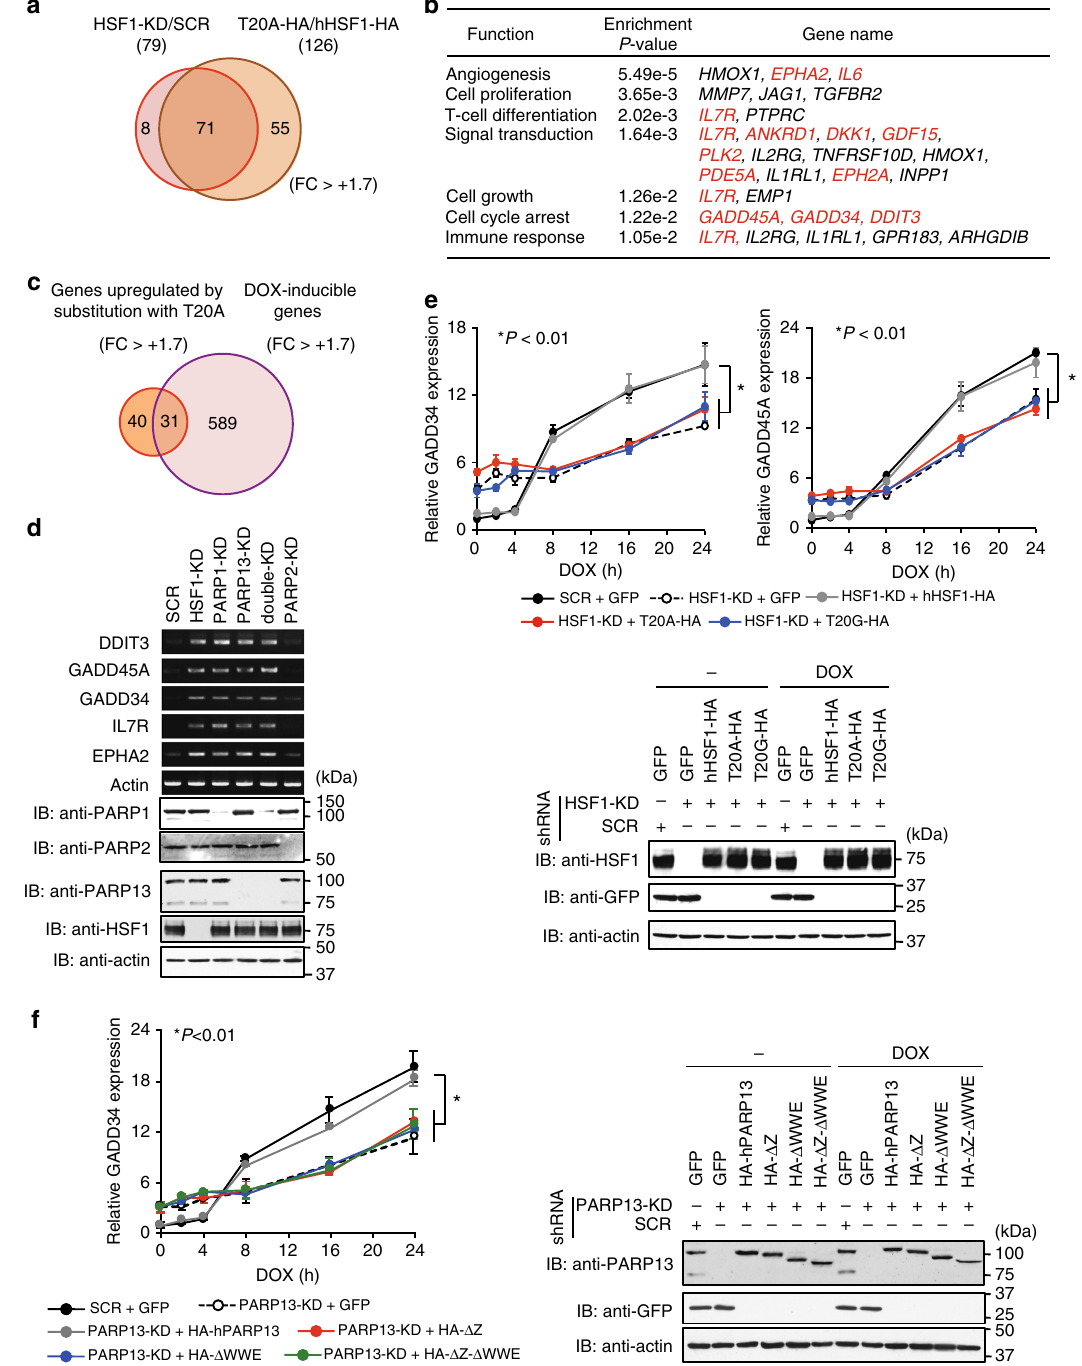
Fig. 3 HSF1 – PARP13 – PARP1 enhances DNA damage-induced gene expression. a Venn diagram showing genes upregulated by HSF1 knockdown and substitution with hHSF1-T20A in HeLa cells (fold change > +1.7; P < 0.05; n = 3). b Gene ontology enrichment analysis of 71 genes upregulated by substitution with hHSF1-T20A. The P -values and gene names associated with each functional category are shown. Names of DNA-damage-inducible genes are indicated in red. c Venn diagram showing genes upregulated by DOX treatment and by substitution with hHSF1-T20A (fold change > +1.7; P < 0.05; n = 3). d Expression of DNA-damage-inducible genes in unstressed condition. RT-PCR analysis of fi ve genes was performed using cells knocked down for HSF1, PARP1, PARP13, or both PARP1 and PARP13 (double-KD) (upper). Cell extracts were also subjected to immunoblotting (lower). e Expression of GADD genes in cells expressing HSF1 mutants. Cells, in which endogenous HSF1 was replaced with each protein, were treated with DOX for the indicated periods. GADD mRNA levels were quanti fi ed by RT-qPCR ( n = 3) (upper). Mean ± s.d. is shown. Asterisks indicate P < 0.01 by ANOVA. Extracts from cells before and after treatment were subjected to immunoblotting (lower). f Expression of GADD34 gene in cells expressing PARP13 mutants. Cells, in which endogenous PARP13 was replaced with each mutant, were treated with DOX for the indicated periods. GADD34 mRNA levels were quanti fi ed by RT-qPCR ( n = 3) (left). Mean ± s.d. is shown. Asterisks indicate P < 0.01 by ANOVA. Extracts from cells before and after the treatment were subjected to immunoblotting